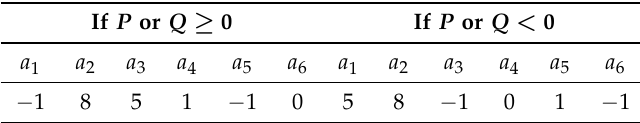
Table 1. Values of constant coefficients of Equations (32) and